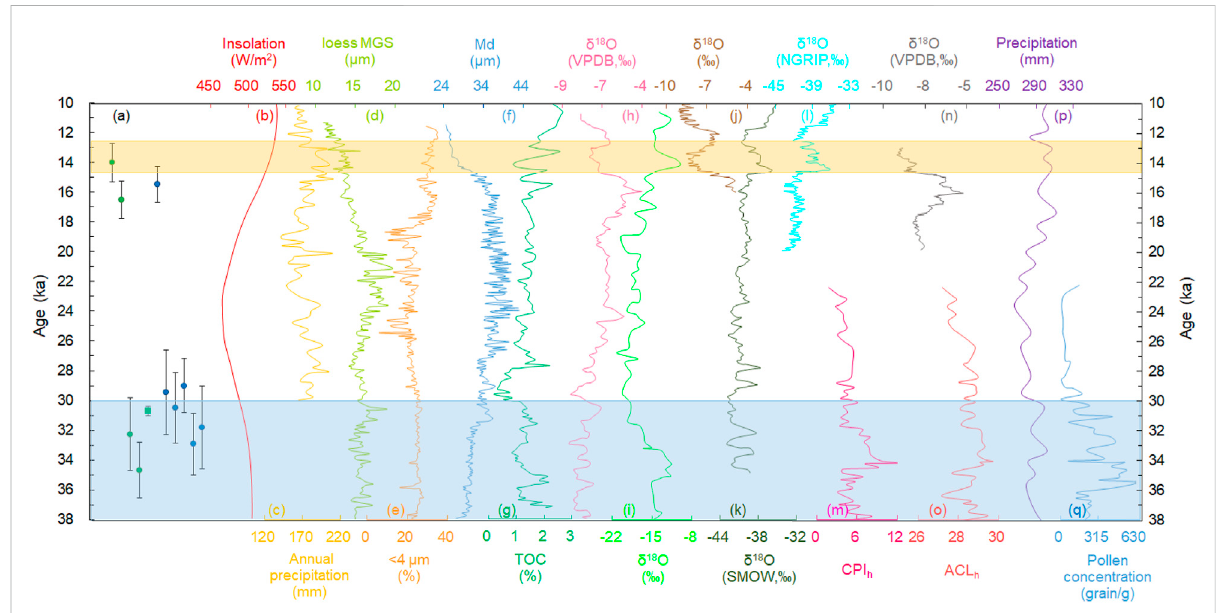
FIGURE 11 (A) TheagesofOFDunitsinCMQandZHKpro fi les(GreenandbluedotsrepresenttheOSLagesofCMQandZHKpro fi lerespectively;Thegreen squarerepresentsAMS 14 CageoftheCMQpro fi le), (B) Variationcurveofsolarradiationinsummerat65 ° N(BergerandLoutre,1991), (C) precipitation reconstructed from rock core in Balikun Lake (Zhao, 2017), (D) The Mz of the Jingyuan loess pro fi le (Wang, 2016), (E) < 4 μ m grain fractions of Shijiu Lake core (Wang, 2016), (F) The Md of the South China Sea SO17940 core (Wang, 2016), (G) TOC content of cores LV53-23 in the Japan Sea (Zong, 2016), (H) The δ 18 O concentration of the stalagmite in Hulu Cave (Wang et al., 2001), (I) The δ 18 O concentration in Guliya ice core (Yao et al., 1997), (J) The δ 18 O concentration of the stalagmite in Dongge Cave (Dykoski et al., 2005), (K) The δ 18 O concentration in GRIP2 (Grootes et al., 1993; Stuiver and Grootes, 2000), (L) The δ 18 O concentrations in Greenland ice cores (Basak et al., 2018), (M) The CPI h in Qarhan Salt Lake sediments (Pu et al., 2010), (N) The δ 18 O concentration of the stalagmite in Haozhu Cave (Zhang et al., 2016), (O) The ACL h in Qarhan Salt Lake sediments (Pu et al., 2010),(P) The simulated precipitation in Central Asia (LiXZ etal., 2013), (Q)The pollen concentrations inQarhan Salt Lake sediments (Puetal., 2010) (The blue and yellow rectangles represent MIS3a and Bøling-Allerød stages